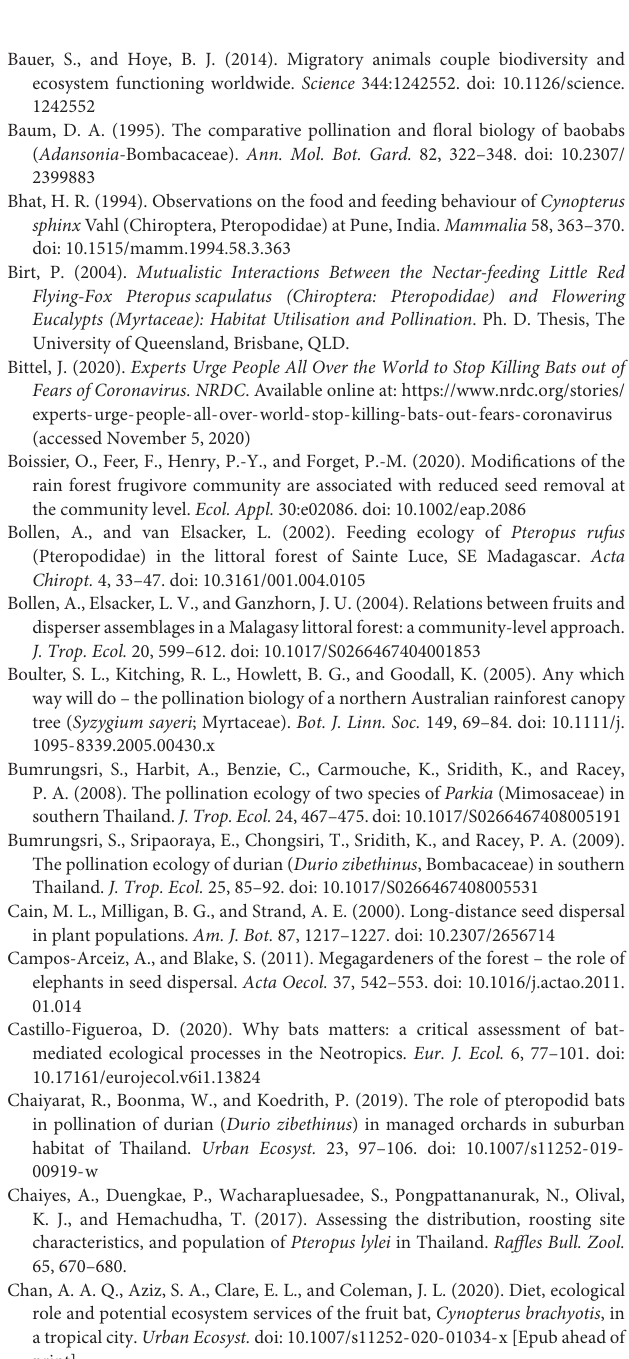
Supplementary Information 5 | Foraging distances of pteropodids. Supplementary Information 6 | Seed dispersal distances of